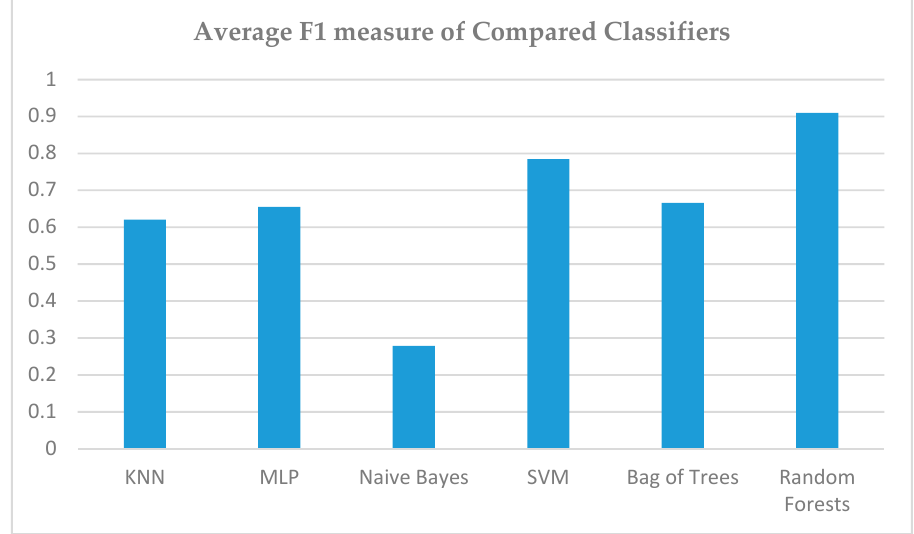
Figure 12. Comparison of F1 measure of all Classifiers.